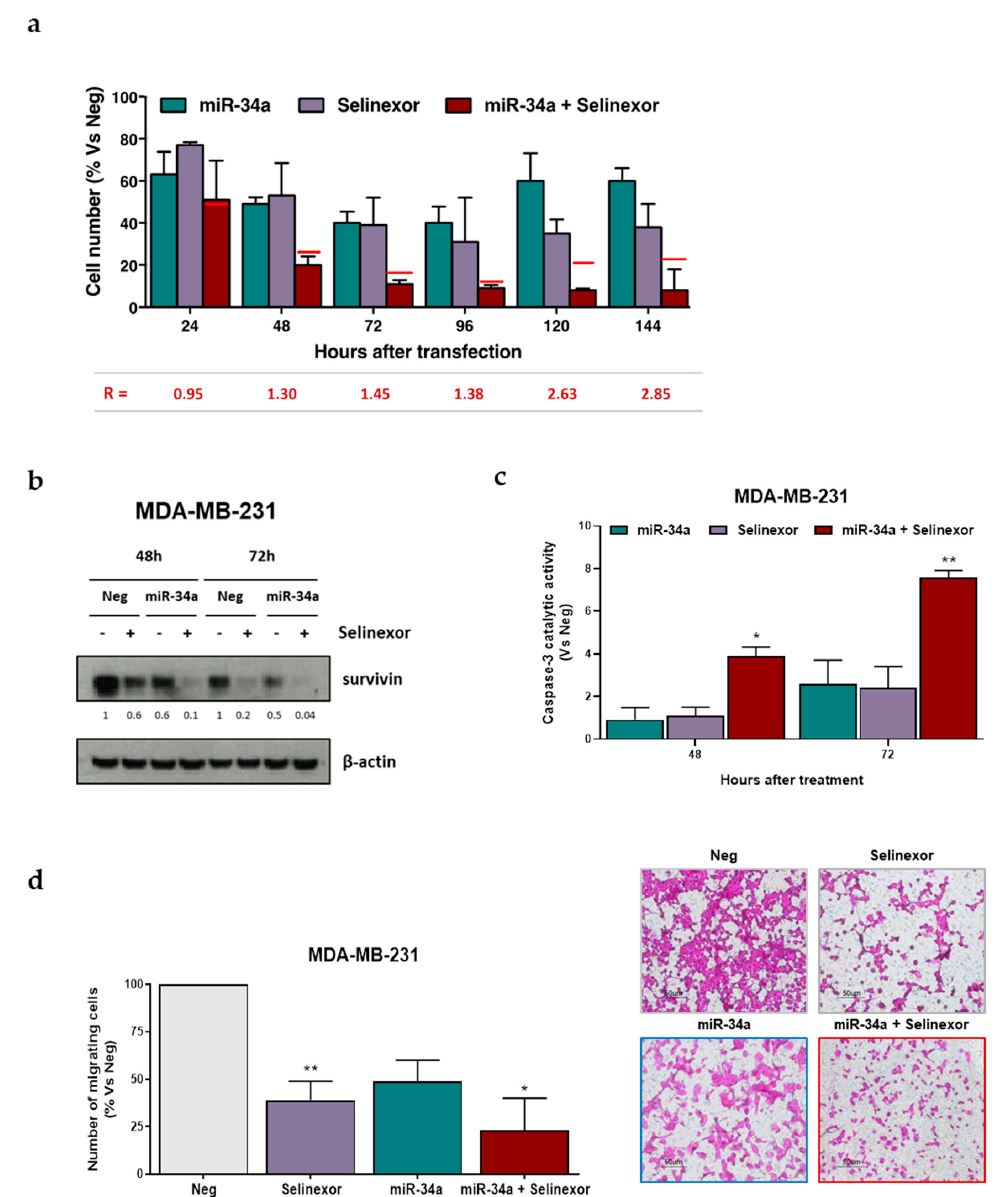
Figure 5. miR-34a ectopic expression improves the activity of selinexor in TNBC cells. ( a ) Effects of miR34a in combination with selinexor on MDA-MB-231 cells growth. Data are reported as percentage of growing cells with respect to Neg-transfected cells (100%), and represent mean values ± SD of three independent experiments. Red lines represent the expected additive effect of the combination, calculated as the product of the effects of the individual treatments. Synergistic ratio (R) is calculated according to [22] (R > 1, synergism; R =1, additivity; R < 1, antagonism). ( b ) Representative western blotting showing the expression of survivin in MDA-MB-231 cells after the transfection with Neg or miR-34a alone or in combination with selinexor (IC 50 at 72 h, as reported in Table 1). β -actin was used to confirm equal protein loading on the gel. Cropped images of selected proteins are shown. For each protein, band density was quantified using ImageJ normalized to loading control and referred to respective untreated control. ( c ) Assessment of caspase-3 catalytic activity in MDA-MB-231 cells after transfection with Neg or miR-34a alone or in combination with selinexor (IC 50 at 72 h). Data are reported as relative absorbance with respect to Neg-transfected cells, and represent the mean values ± SD of at least three independent experiments. ( d ) Left: Quantification of migration cells. Data are reported as the percentage of migrated cells with respect to Neg-transfected cells (100%), and represent mean values ± SD of three independent experiments. Right: representative photomicrographs of a transwell migration assay carried out on MDA-MB-231 cells 48 h after transfection with Neg or miR-34a either alone or in combination with selinexor. * p < 0.05, ** p < 0.01, Student (cid:48) s t